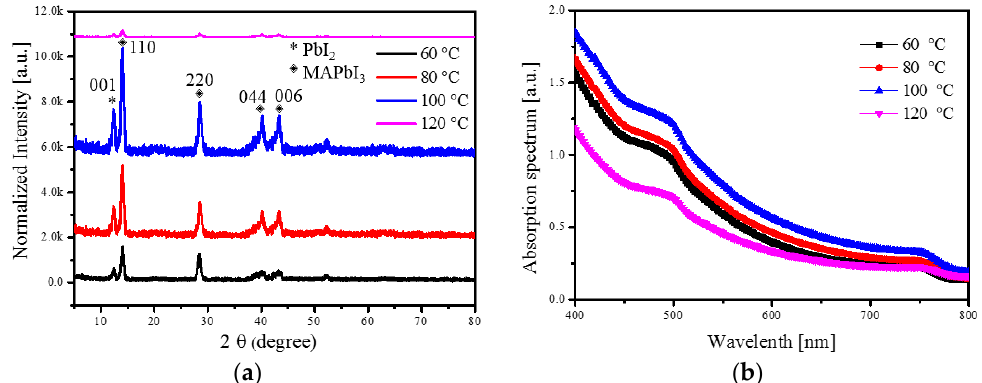
Figure 5. ( a ) XRD patterns and ( b ) absorption spectra of 192 nm thick MAPbI 3 layer with different annealing temperatures.